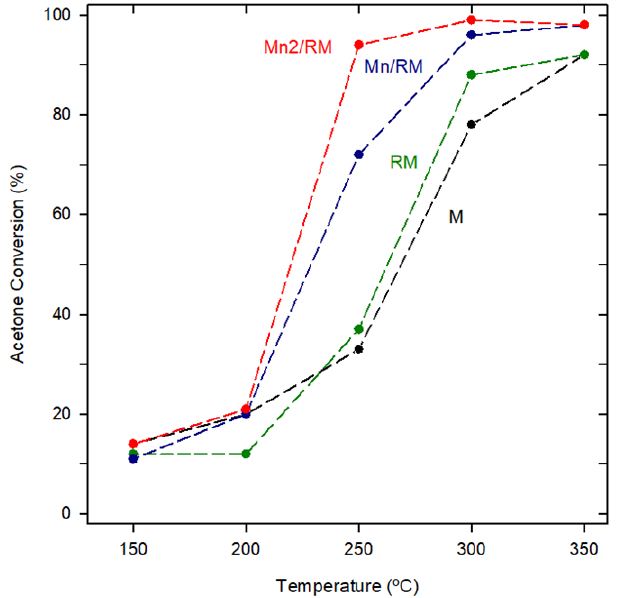
Figure 7. Catalytic activity of the studied samples in the acetone oxidation.